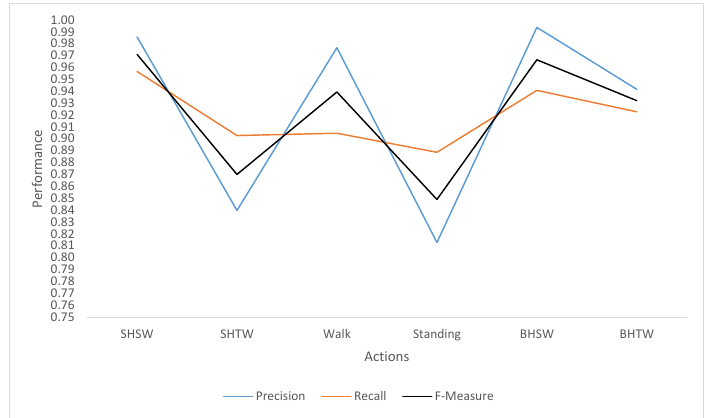
Figure 6. Performance of the proposed